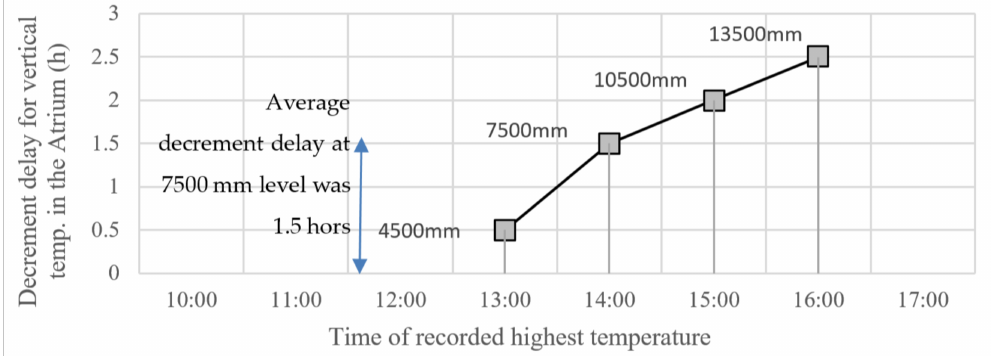
Figure 15. Decrement delay inside the covered atrium in Building C at di ff erent vertical